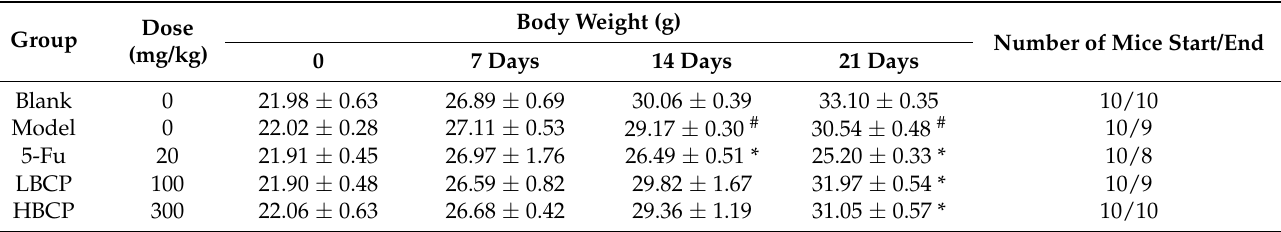
Table 2. Effects of BCP on the body